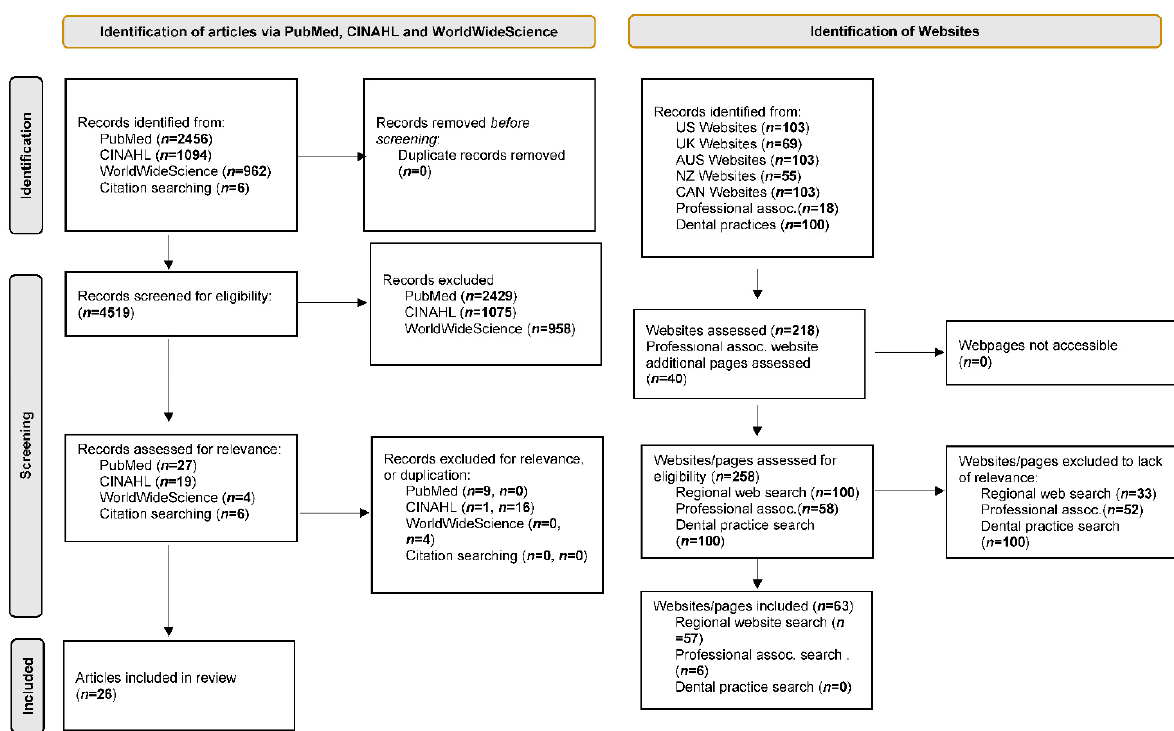
Figure 1. PRISMA flow